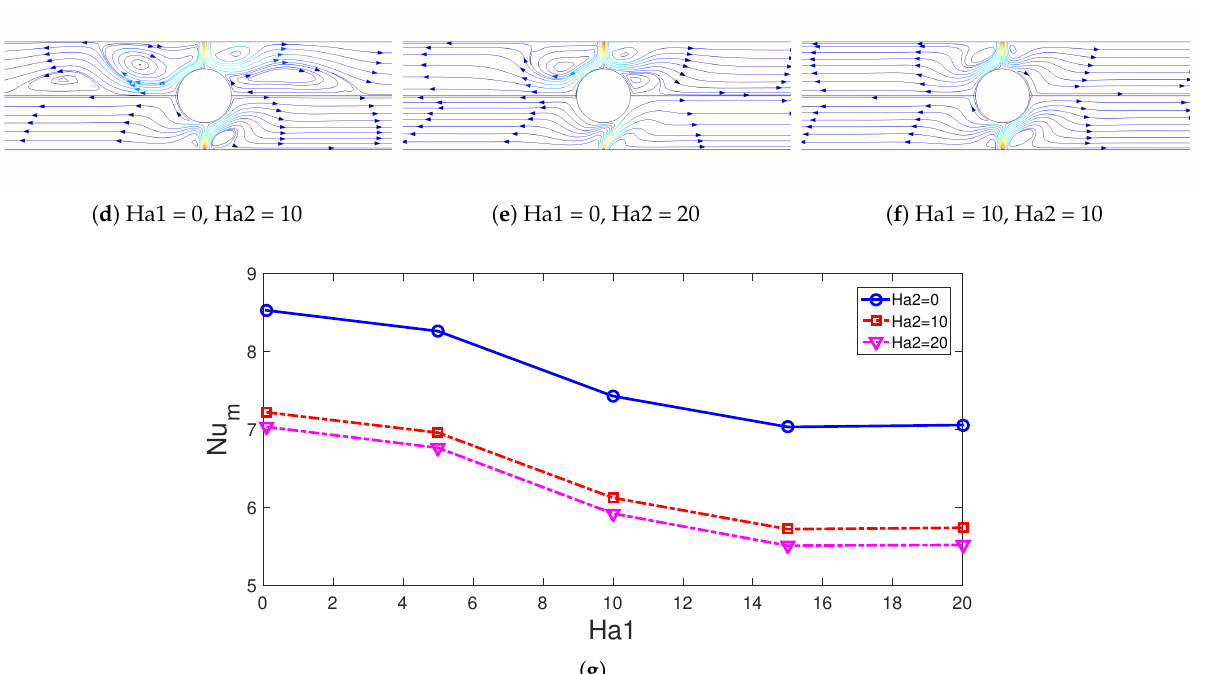
Figure 5. Impacts of MaF strength of the domains (Ha1, Ha2) on the distribution of streamlines ( a – f ) and average Nu variations ( g ) (Re1 = Re2 = 200, Rew = 100, H = 8 w, r = 4